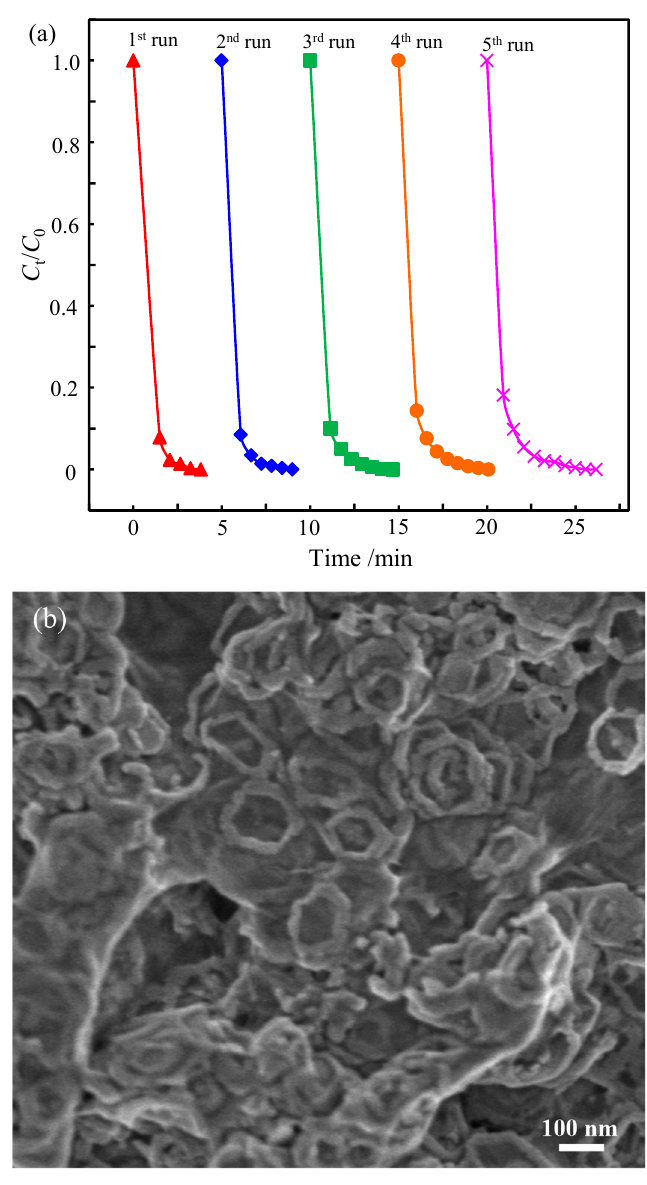
Figure 8. ( a ) The reusability of CoOOH/rGO for the catalytic reduction of p-NP. ( b ) SEM image of CoOOH/rGO after the reduction of